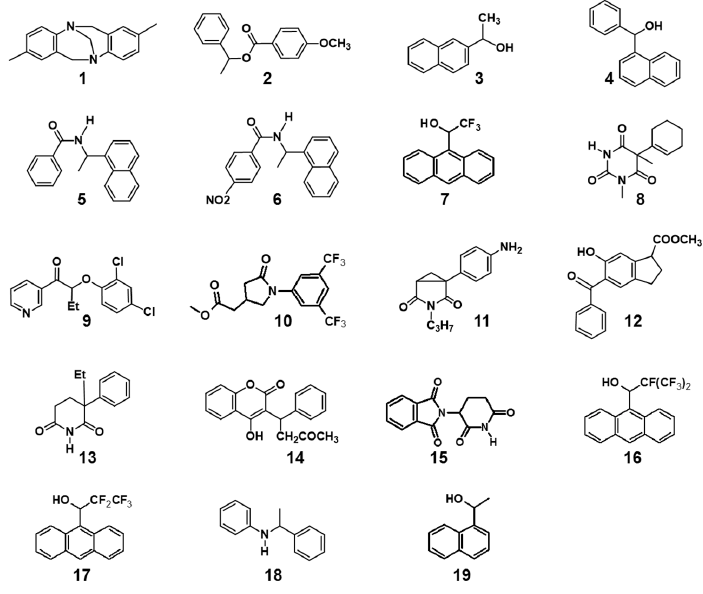
Figure 2. Structures of the tested racemic compounds.